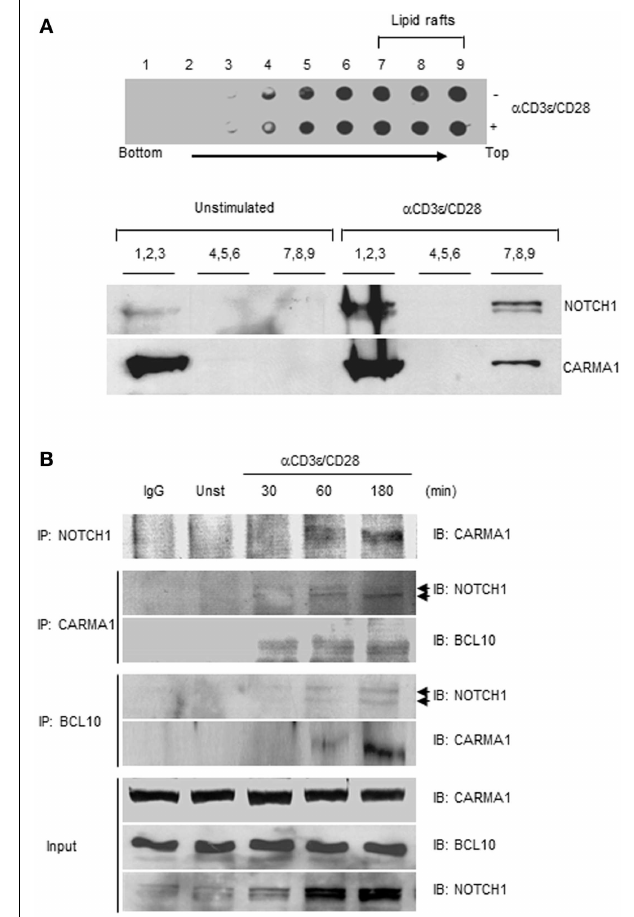
FIGURE 3 | NOTCH1 interacts with CARMA1 and BCL10 following stimulation with anti-CD3 ε and anti-CD28 . (A) JurkatT cells were stimulated with plate-bound anti-human CD3 ε and anti-human CD28 and subjected to sucrose gradient centrifugation. All fractions were analyzed by dot blot with anti-cholera toxin-conjugated HRP (upper panel). Pooled fractions were immunoblotted with indicated antibodies (lower panel). (B) JurkatT cells were stimulated as in (A) for the indicated time periods, followed by co-immunoprecipitation with antibodies specific for NOTCH1, CARMA1, or BCL10. Eluates were subjected to immunoblotting with indicated antibodies. 1/100 of input (shown) was immunoblotted with anti-CARMA1, anti-BCL10, and anti-NOTCH1. Arrow heads beside IB: NOTCH1 represent 120kDa, transmembrane form (upper arrow head) and 110kDa intracellular form (lower arrow head) of NOTCH1. Data are representative of at least three independent